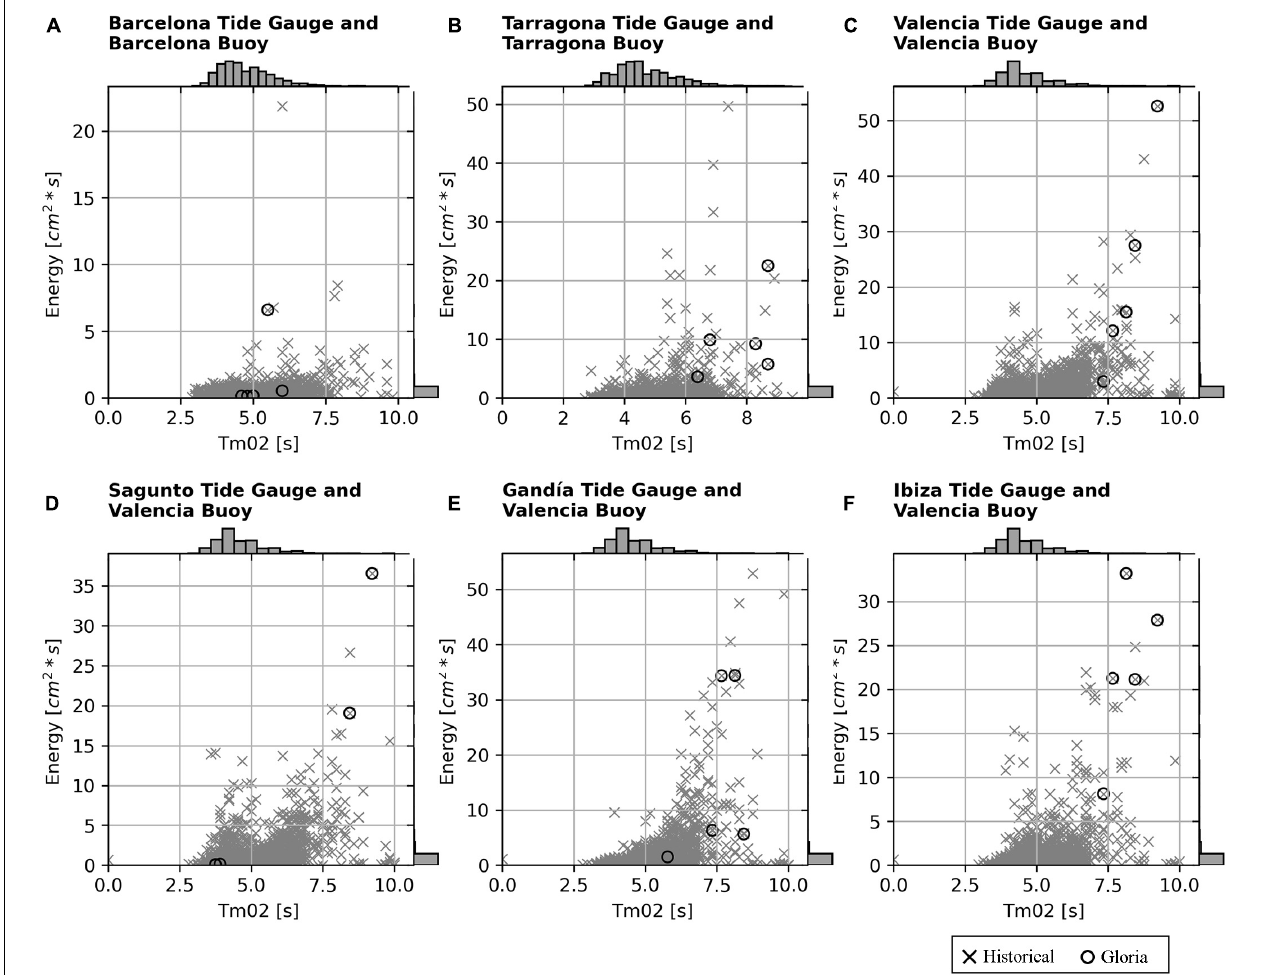
FIGURE 7 | Infragravity band (30 s-5 min band) energy at tide gauges, vs T m 02 at the closest buoy, for the historical tide gauges record at Barcelona (A) , Tarragona (B) , Valencia (C) , Sagunto (D) , Gandía (E) , and Ibiza (F) . The historical maximum energy in this band was recorded in Valencia, Sagunto and Ibiza during Gloria.